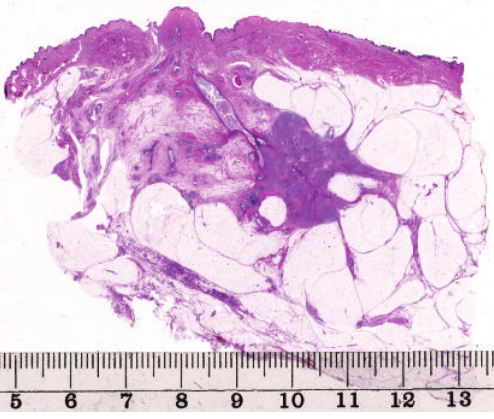
Figure 4: Invasive breast carcinoma with an in situ component involving a lactiferous duct leading to the invasive